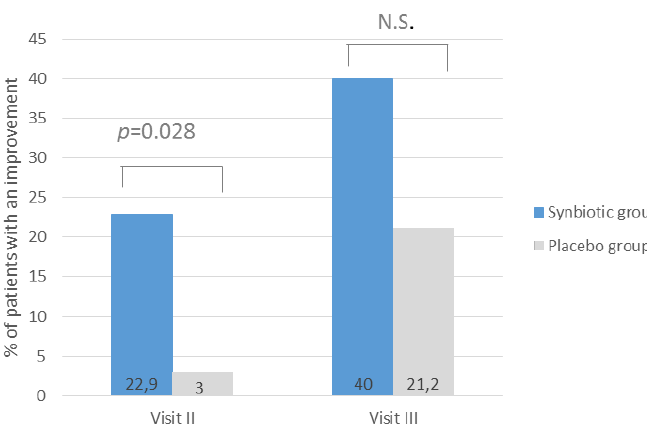
Figure 2. The percentage of patients reported an improvement in dissatisfaction with bowel habits assessed by IBS-SSS scale after synbiotic intervention lasting 4 weeks (visit II) and 8-weeks (visit III). An improvement was defined as a 50-point decrease compared to baseline. N.S. = no significance ( p > 0.05).